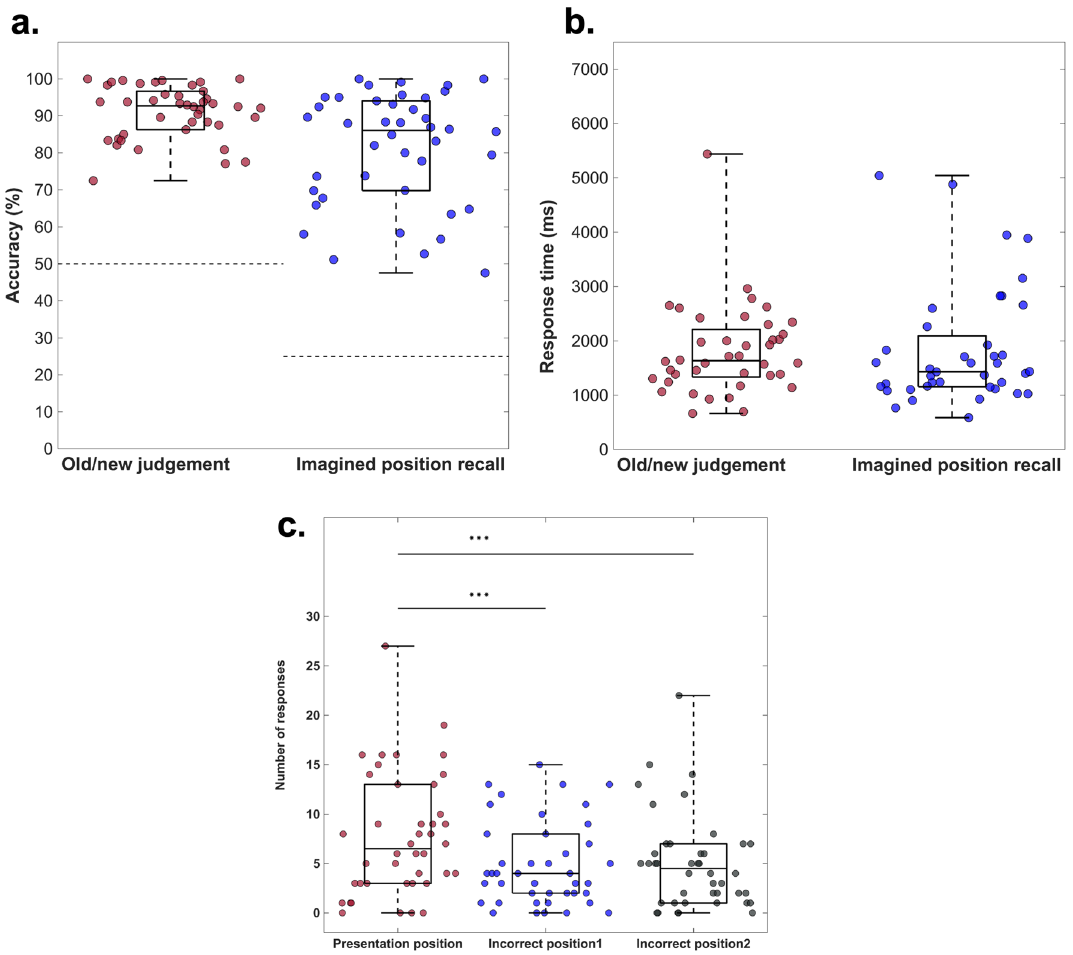
Figure 3. Behavioral performance. a . Boxplot illustrating the distribution of average accuracy (%) for the old/ new recognition and imagination position recall task. All participants show above-chance performance (chance level recognition task: 50%; recall task: 25%). b . Boxplot showing the distribution of average reaction times (ms) for the two tasks: M recognition = 1538.80 ms, SD recognition = 102.70 ms; M recall = 1364.10 ms, SD recall = 199.25 ms. c . Boxplot illustrating the distribution of incorrect responses. The Y-axis denotes the frequency of reporting the respective incorrect position, where the maximum value is